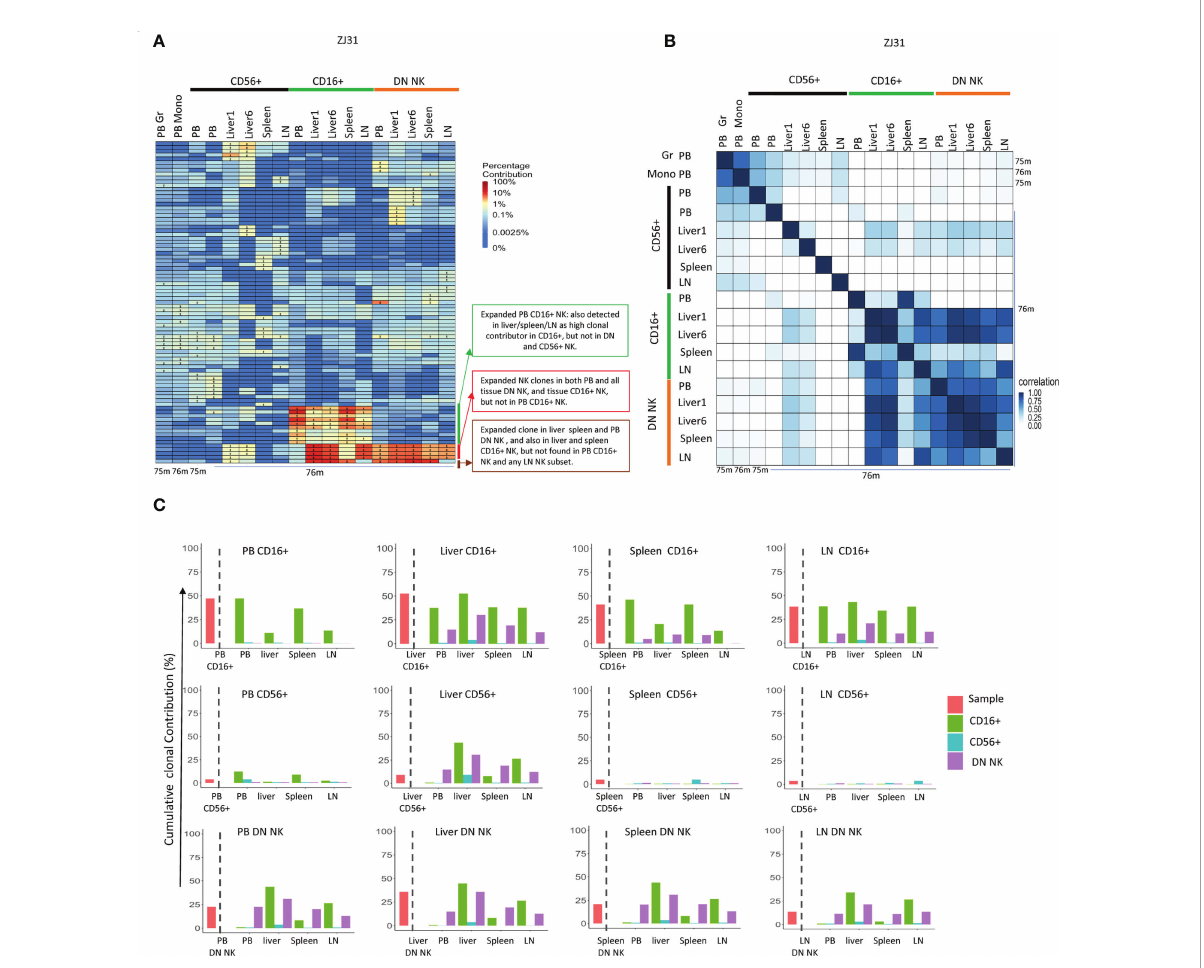
FIGURE 5 Tissue NK subset clonality analyses (A) Heat maps of the natural log fractional abundance of the highest contributing clones de fi ned as all barcodes present as a top 10 highest contributing barcode in at least one of the PB granulocytes, monocytes or PB or tissue NK cell subpopulations in animal ZJ31. Samples were collected from ZJ31 at necropsy performed 76 months post-transplantation. Heatmaps were constructed as in Figure 2A. (B) Pairwise Pearson correlation coef fi cients heatmaps showing the pairwise clonal correlations of contributions from all barcodes retrieved from PB granulocytes, monocytes and PB and tissue NK cell subsets at 76 months post-transplantation. The color scale for r values is shown on the right of the panel. (C) The clonal contributions of the aggregate top 10 clones from one NK population to all other NK populations (calculated as detailed in Figure 4E). The schematic panel on the left diagrams how each panel is organized, with the contribution of the aggregate top 10 clones from the index sample to itself shown to the left of the dotted line, and to other NK populations to the right of the line, organized by tissue and by NK cell subset. * in the barcode heatmap indicates the barcode is one of the top 10 for that